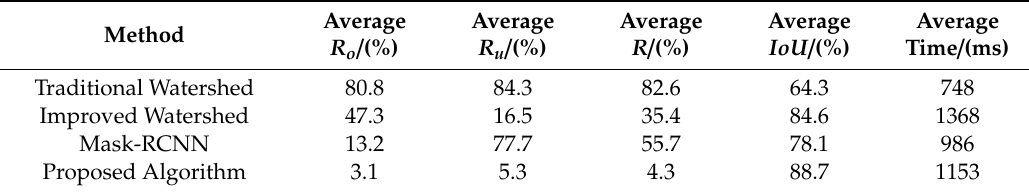
Table 3. Average results statistics for 300 apple images using di ff erent